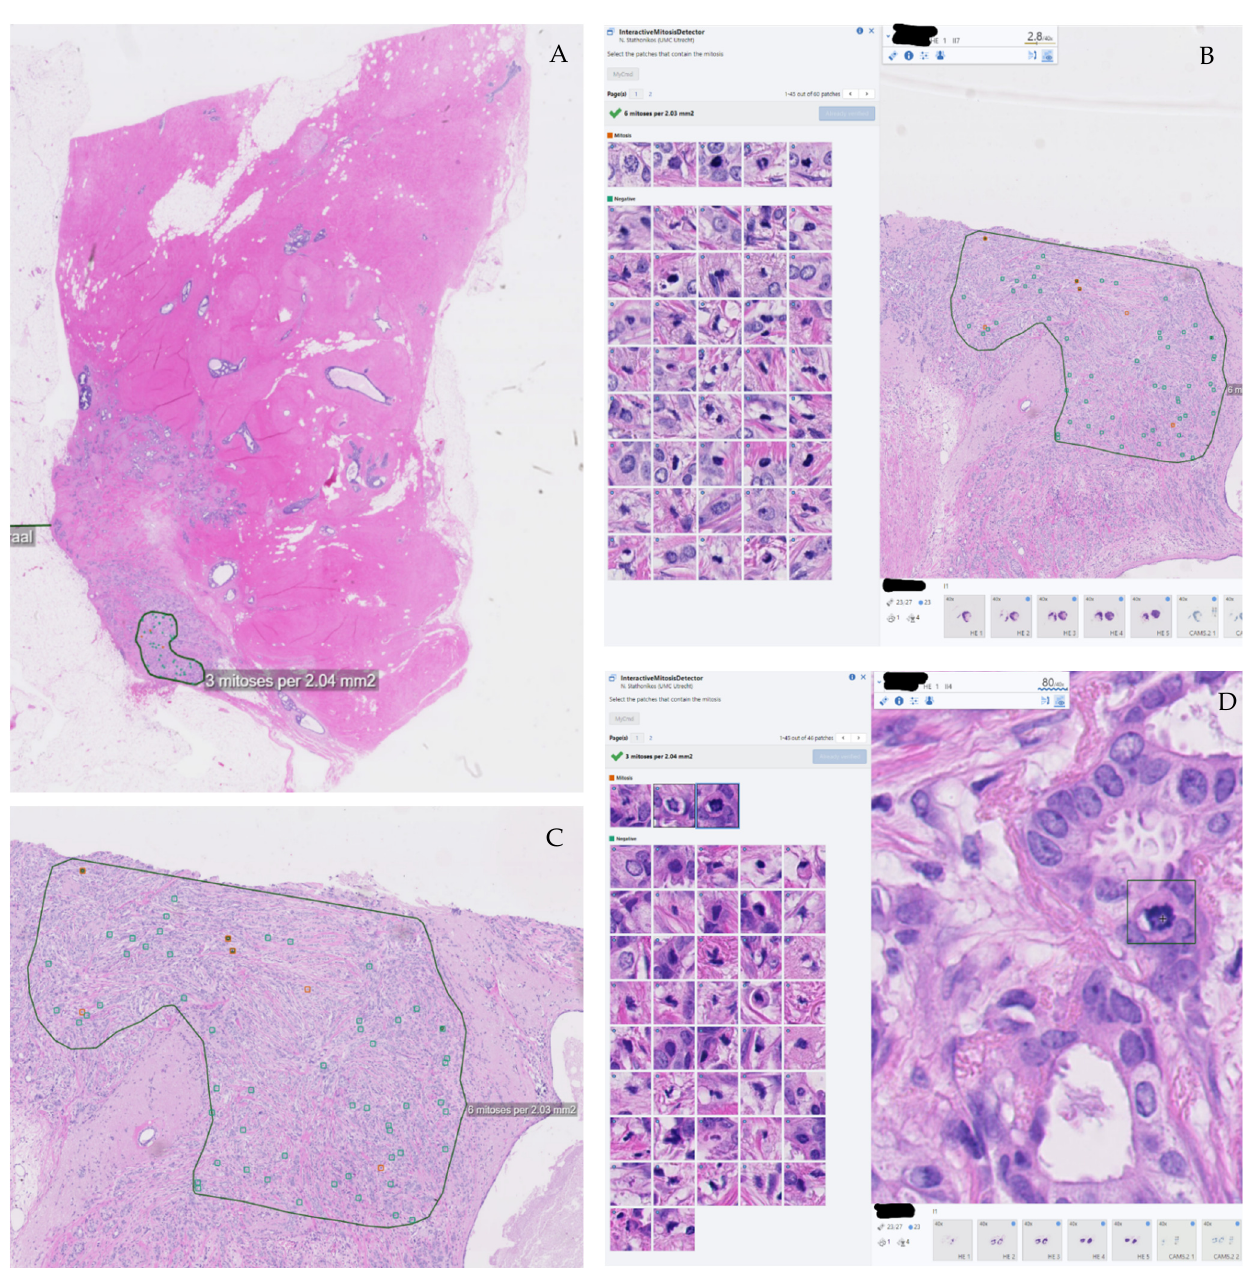
Figure 1. In-house developed AI algorithm for mitotic figures recognition. ( A ) Selecting a region of interest. ( B ) and ( C ) Interactive Mitosis Detector, with gallery ( B ) and without gallery ( C ). The detector highlights those areas suspicious for mitosis with orange, those negative for mitosis as green. ( D ) Close-up of mitotic figure (mitotic figure selected by the pointer on the right in the gallery), recognized by the algorithm.